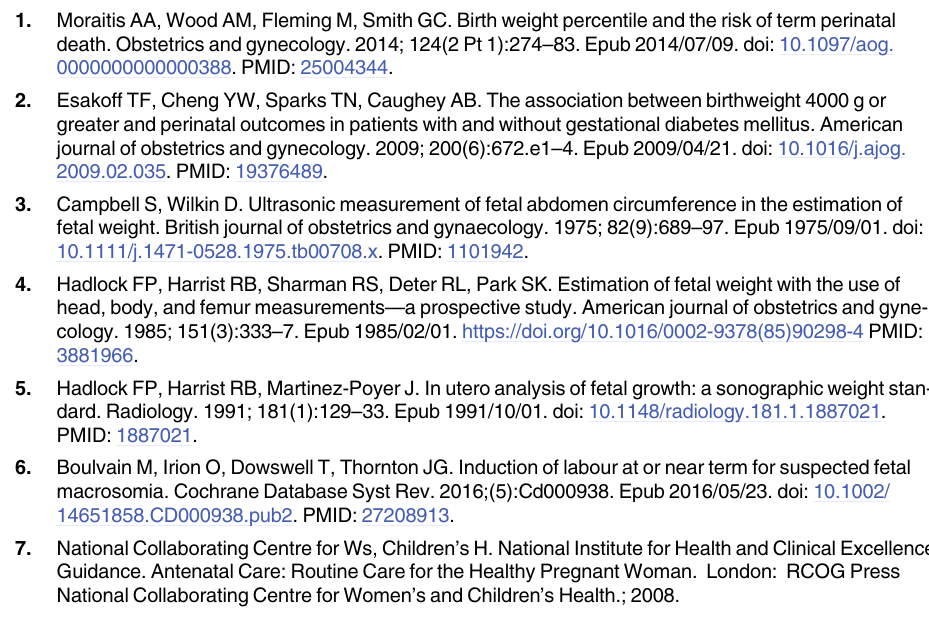
S2 Fig. Deeks’ funnel plot asymmetry test.